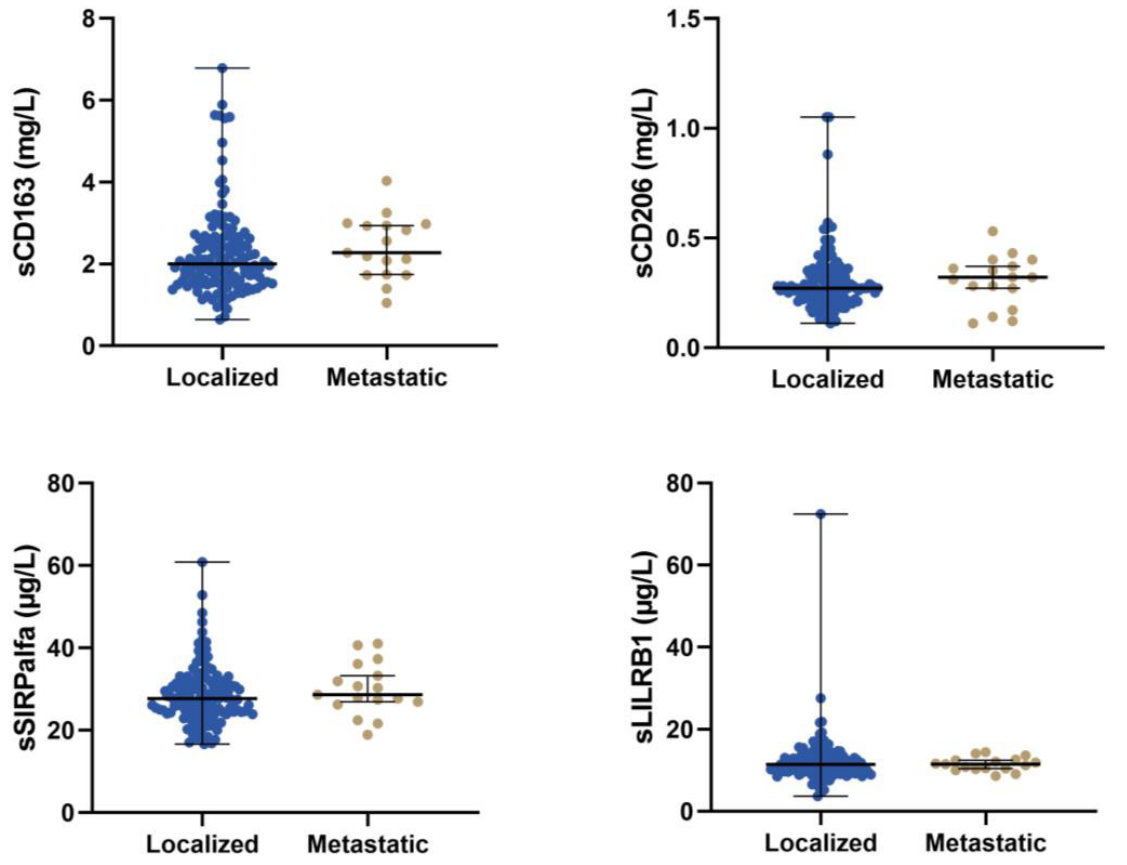
Figure 4. The concentration of the four different macrophage biomarkers for patients with localised or metastatic disease.